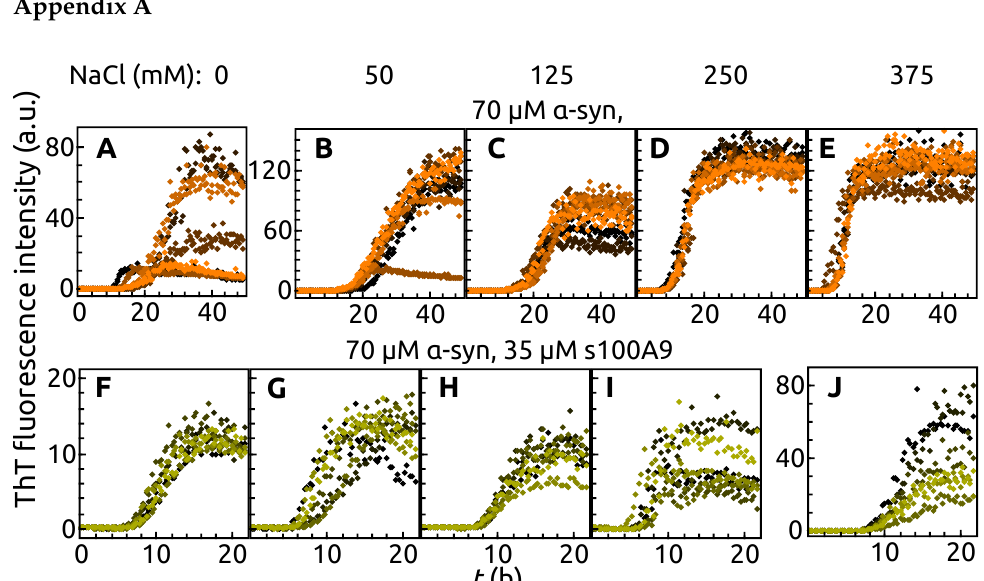
Figure A1. Aggregation kinetics of α -syn without ( A – E ) and with S100A9 ( F – J ) in a presence of different NaCl concentrations: 0mM, 50mM, 125mM, 250mM, 375mM. Each sample represented by 6 aggregation curves (6 repeats). Protein solution: 70µM α -syn, 0 or 35µM S100A9, 50µM ThT, 0.02% NaN 3 , PBS buffer, pH7.4.